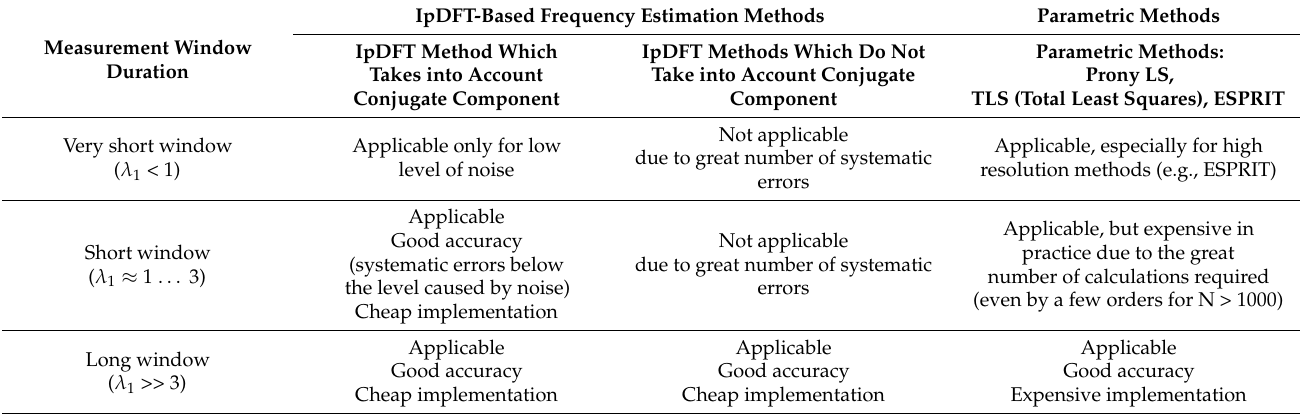
Table 1. Qualitative comparison of the IpDFT method with GMSD windows (which takes into account the conjugate component during derivation of the estimation formula) vs. parametric methods depending on the normalized frequency λ 1 (the number of signal periods in the measurement